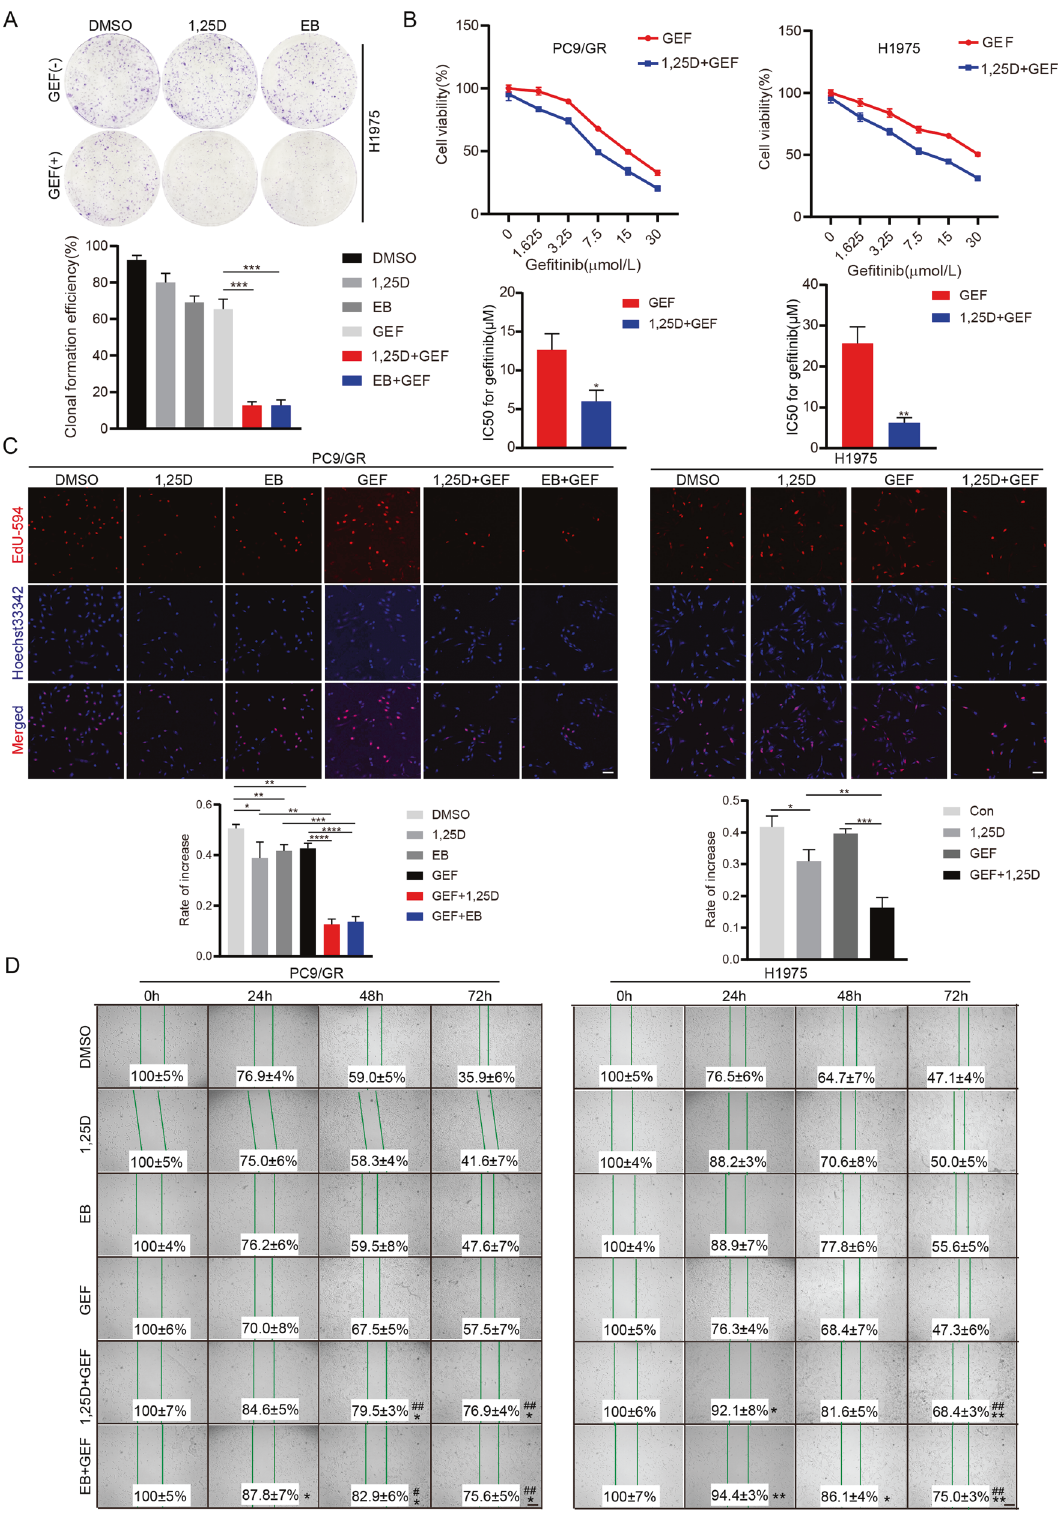
The AKT pathway is a major downstream effector of EGFR signaling and has been implicated in cell survival. Pro ‐ survival AKT is active in ge fi tinib ‐ resistant EGFR mutant NSCLC cells [28]. Activation of AKT signaling is a convergent feature in NSCLC patients and an EGFR mutation with acquired resistance to EGFR-TKIs may be due to multiple underlying mechanisms [29, 30]. Moreover,